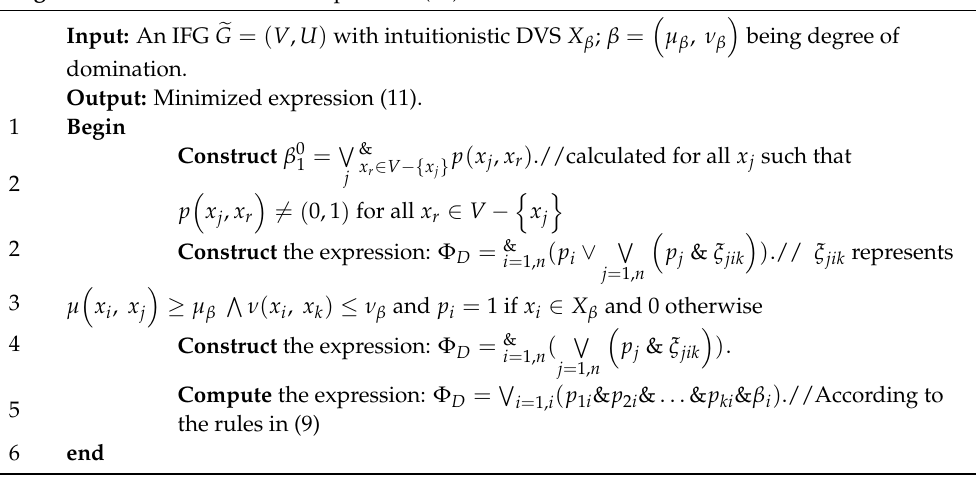
Algorithm 2. Minimization of expression (11)